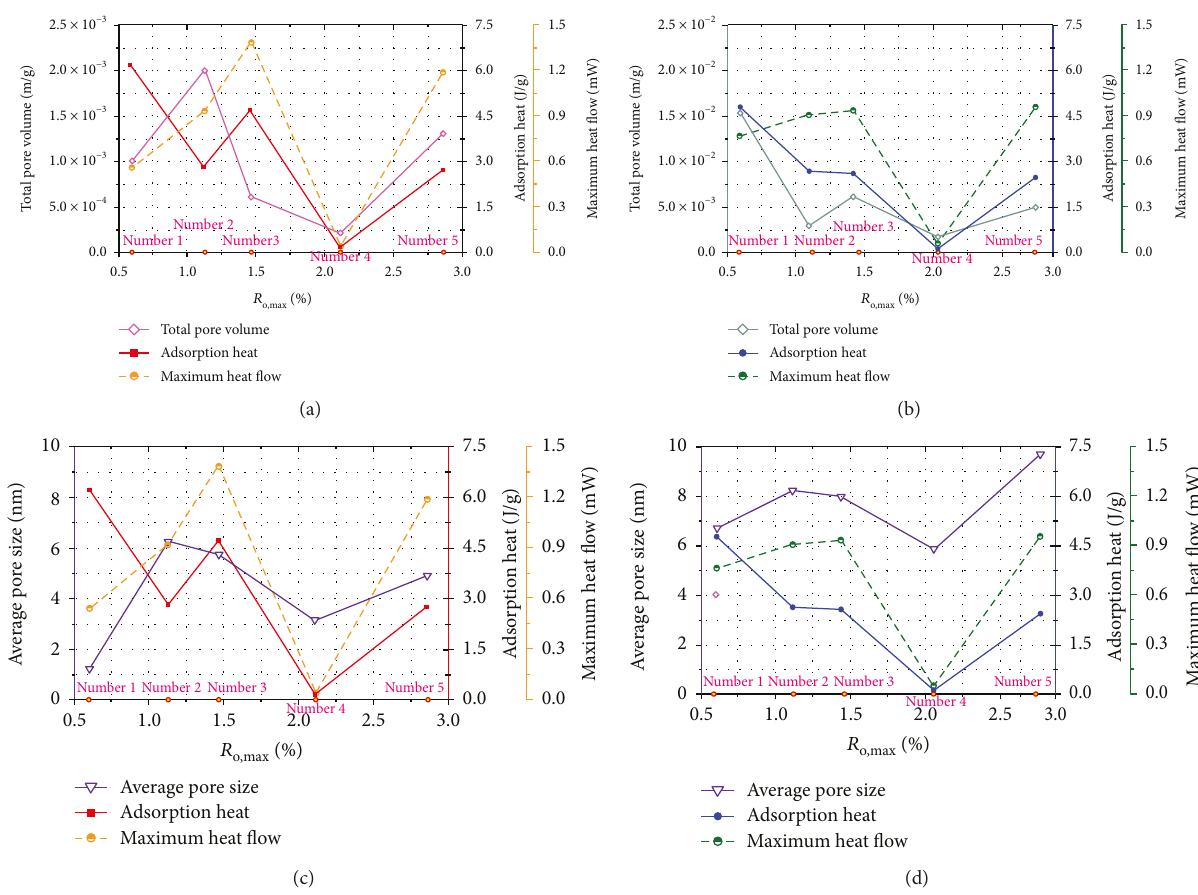
Figure 11: Correlation between the adsorption heat and the total pore volume of VC (a) and IC (b) and the average pore diameter of VC (c) and IC (d),